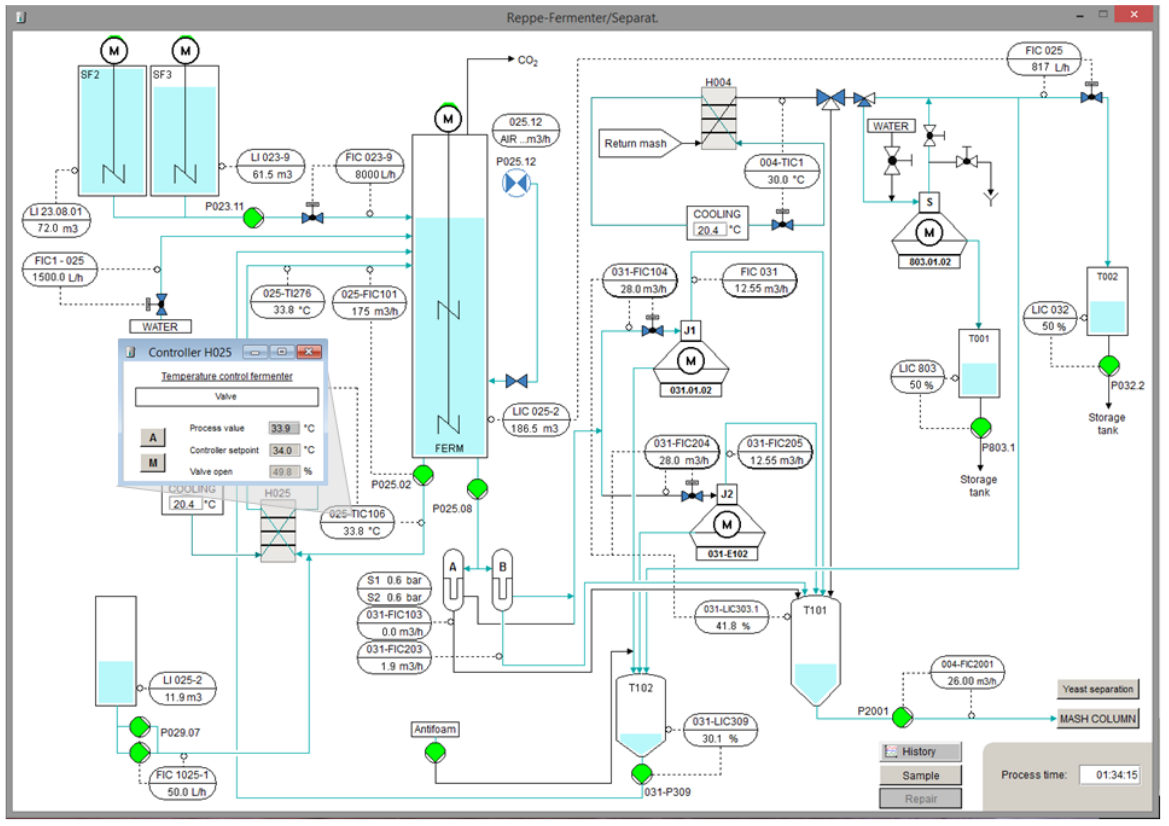
Figure 7. Additional example of a GUI of the OTS as designed from the conceptual design premises. The figure shows the fermentation process section of the virtual plant with a controller sub-window for cooling of the broth. Sampling for off-line analysis can be initiated via the button “Sample”. The analytical results are then displayed in a data table window for e.g. pH and concentrations of glucose and dry mass (not shown in